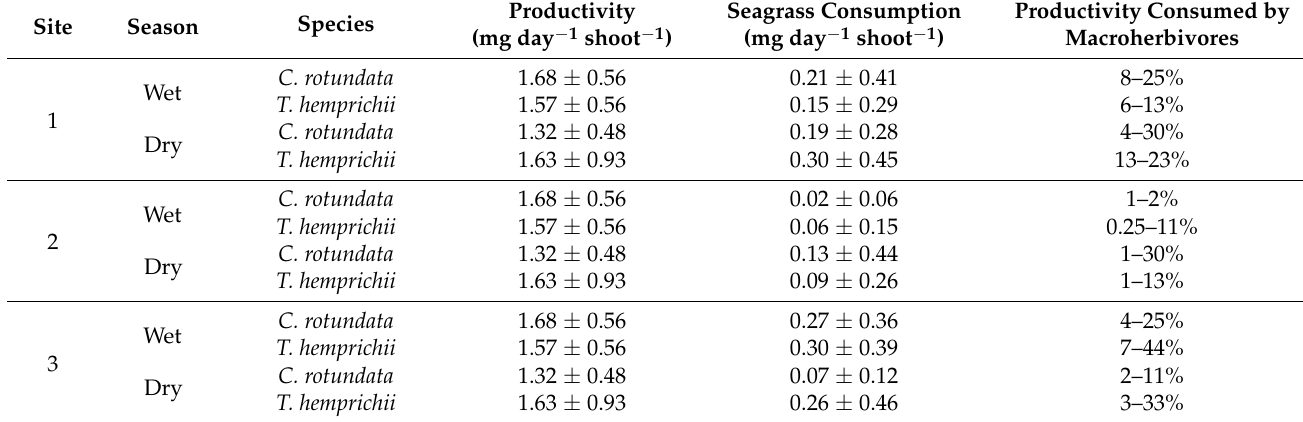
Table 2. Percentage of daily seagrass productivity consumed as a percentage of daily productivity per shoot in the wet season (February, October, December) and dry season (April, June, August). Productivity and seagrass consumption shown as mean ±